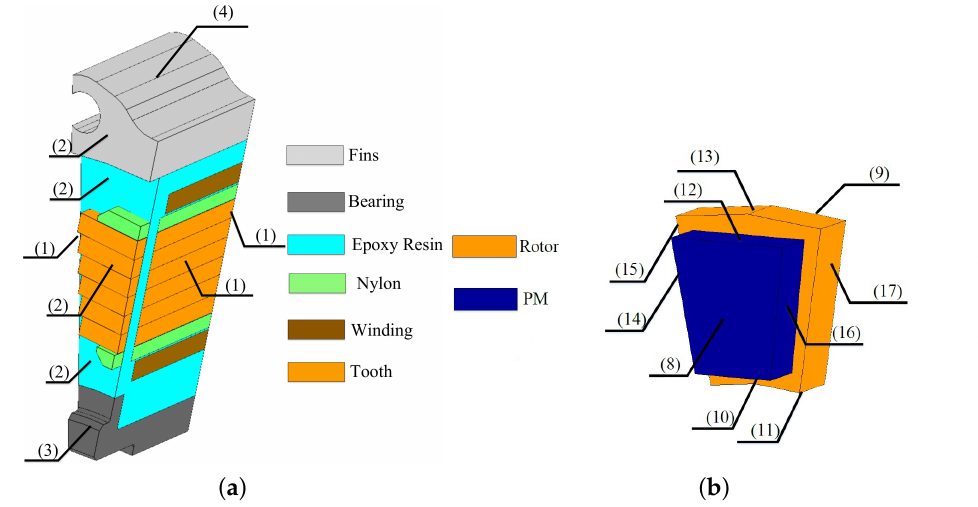
Figure 4. Machine Modeled parts ( a ) Stator modeled part: (1) thermal insulation; (2) stator facing rotor upper part; (3) stator facing rotor lower part; (4) stator side wall. ( b ) Rotor modeled part: (8) rotor facing stator upper; (9) rotor left side; (10) PM lower; (11) rotor lower; (12) PM upper; (13) rotor upper; (14) PM left; (15) PM right; (16) rotor facing